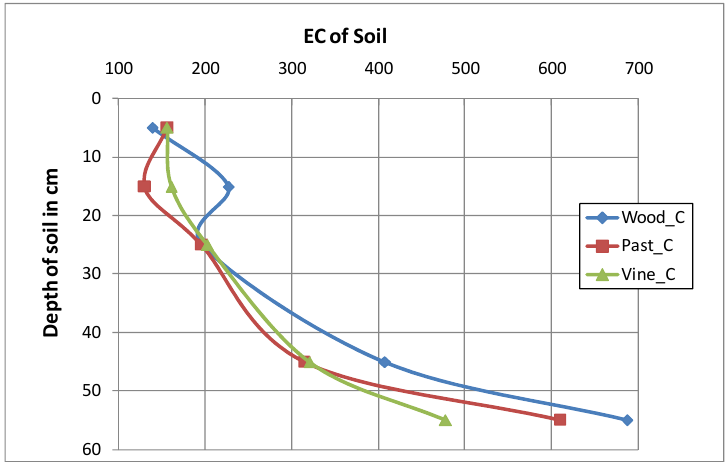
Figure 4. Salinity (EC = Electrical Conductivity) depth profiles of soil under different Land use land cover. Note that: Wood_C = Woodland consistency, Past_ = Pasture/scrubland consistency, Vine_C = Vineyard